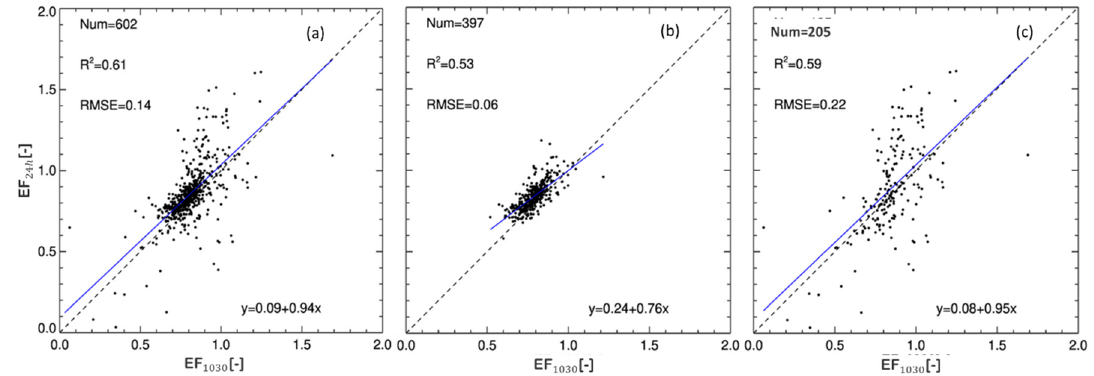
Figure 7. Comparison between EF 1030 (the EF value at 1030 UTC) and EF 24h (the average value of EF for the 24 h) for ( a ) all days, ( b ) warm times and ( c ) cold times, respectively. The black dash line is 1:1 reference line and the blue line is the linear fit line.